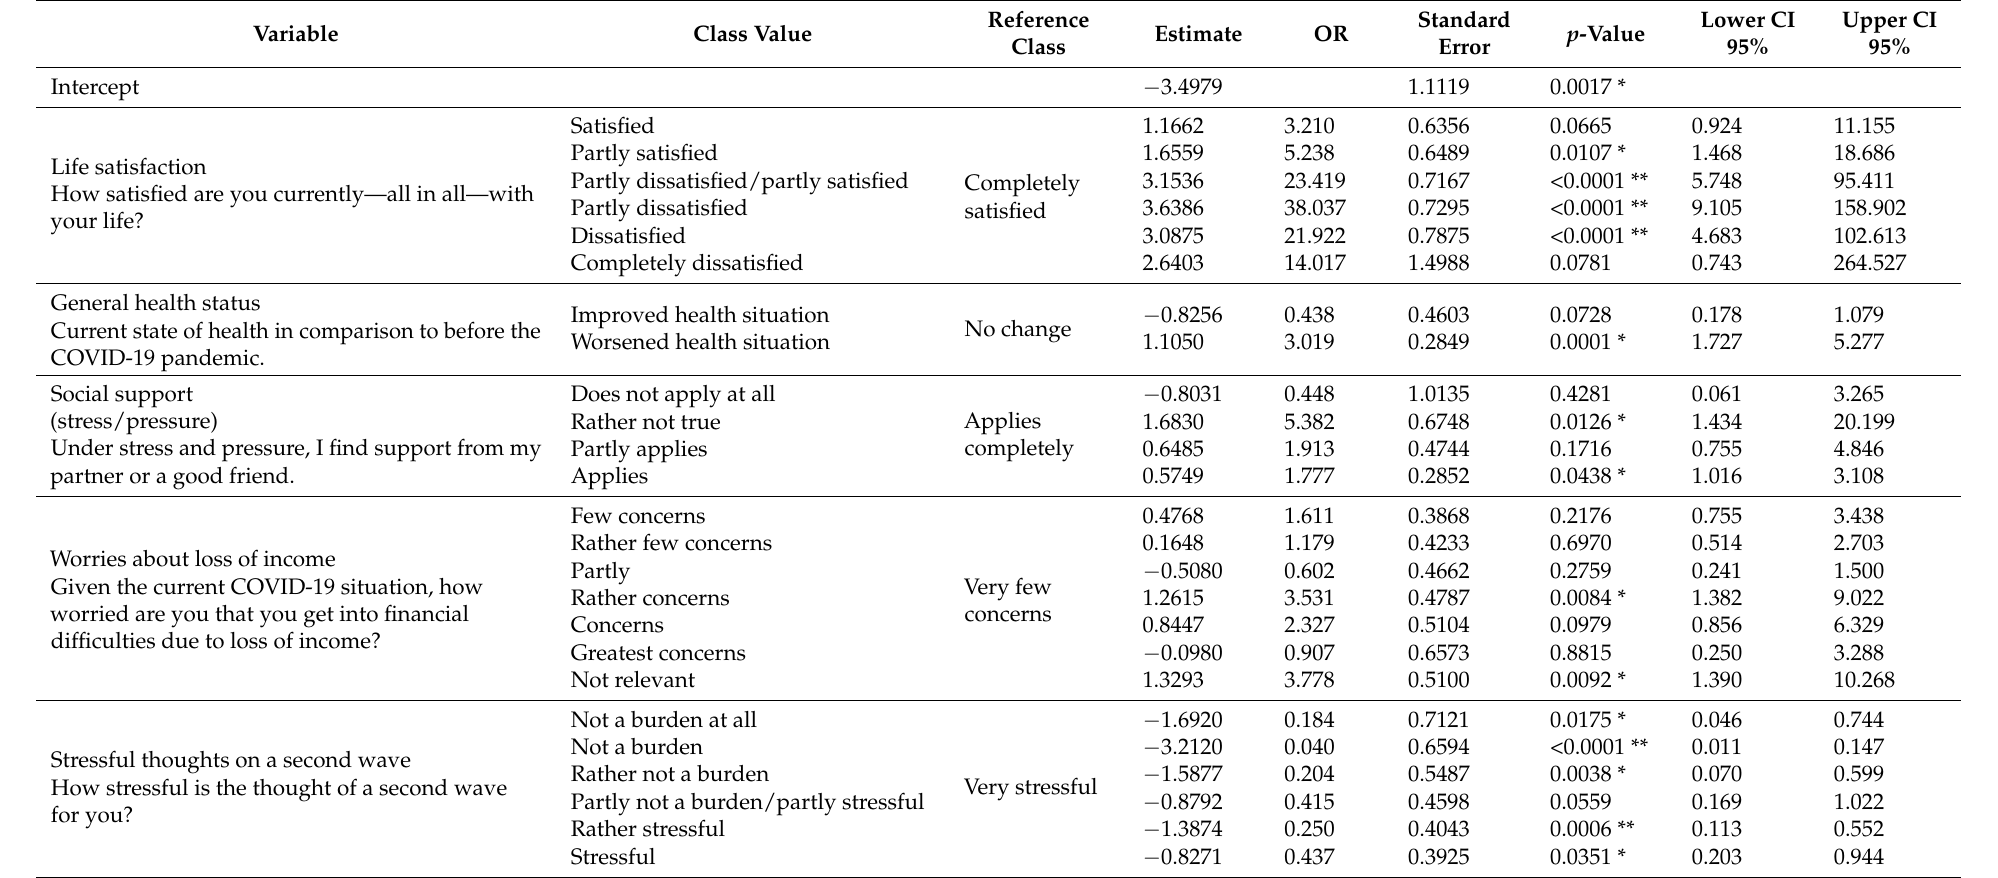
Table 4. Final regression